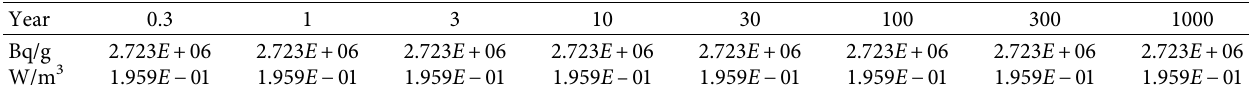
Table 6: Radiological characteristics of I